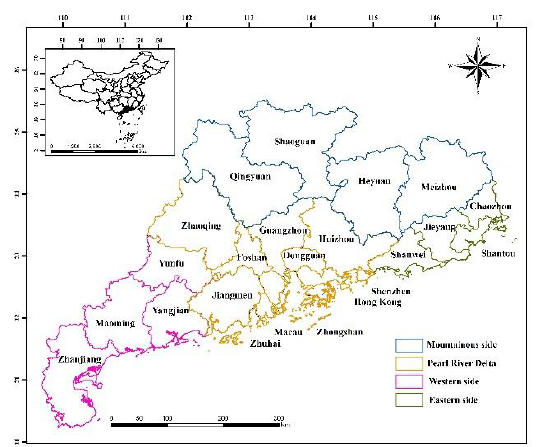
Figure 1. The geographical location of the study